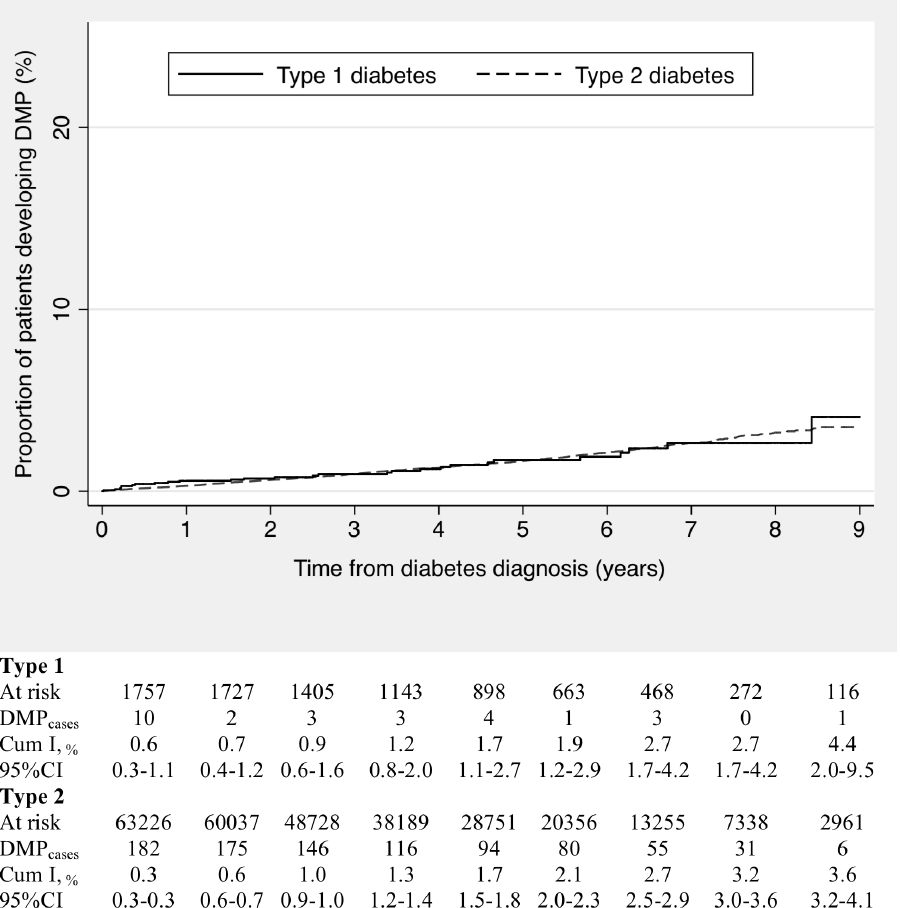
Figure 3. Kaplan-Meier curves and table of annual cumulative incidence of diabetic maculopathy from the date of first diabetes diagnosis recorded.